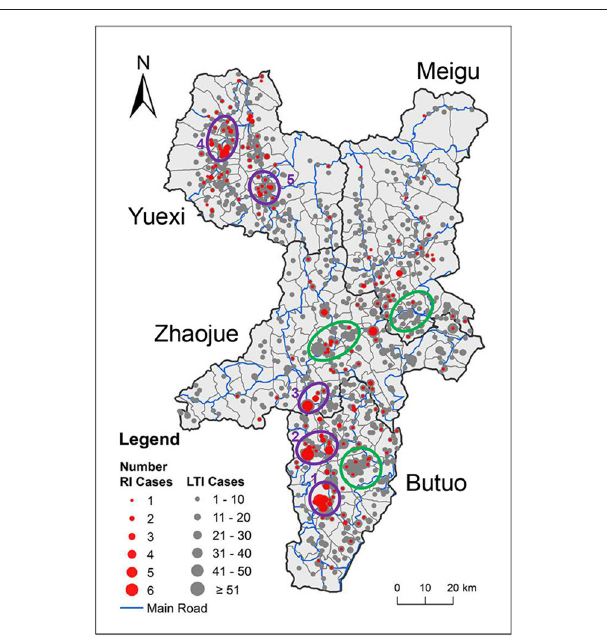
FIGURE 2 | Geographic distribution of newly diagnosed HIV cases. The locations of newly diagnosed HIV cases were mapped onto the administrative map of the four key counties. The size of the circle indicates the number of cases, while red and gray indicate recently infected and long-term infected HIV cases, respectively. County borders are indicated by black lines. Town borders are indicated by gray lines, and main roads are indicated by blue lines. Purple rings 1–5 denote spatial clusters of recently infected HIV cases. Green rings denote clusters of long-term infected cases that overlap with only a few recently infected HIV